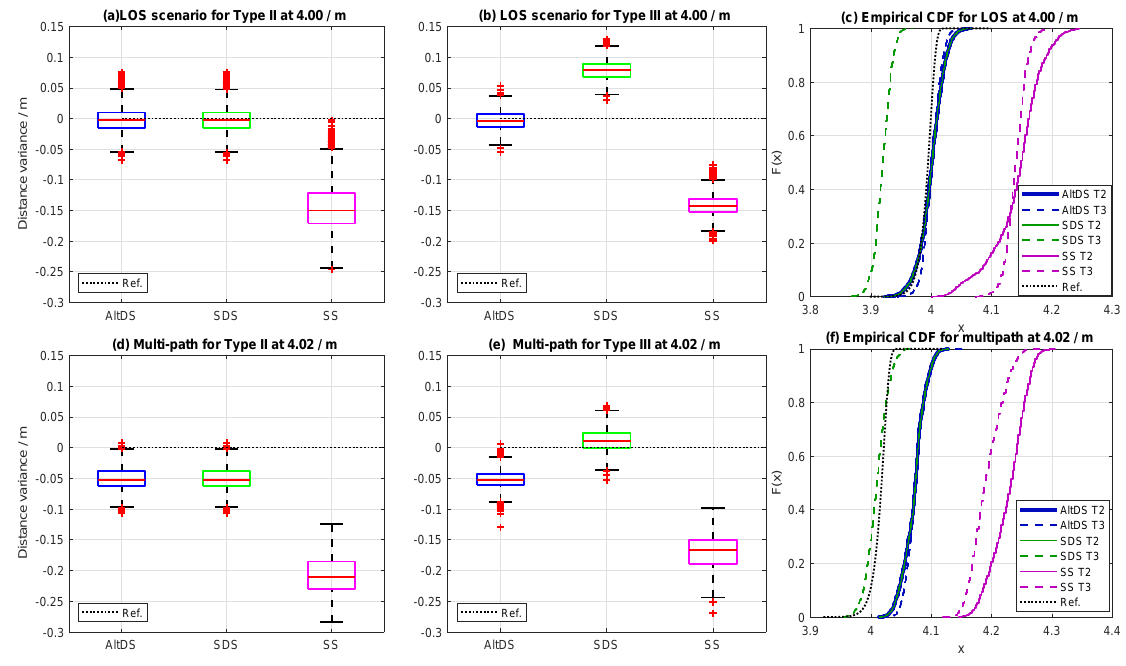
Figure 9. Comparison of Type II and Type III for LOS and multipath scenarios at a 4 m true reference. ( a – c ) measured data from the LOS (Hall), and ( d – f ) measured data from the multipath (Corridor)